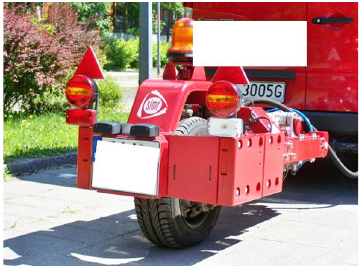
Figure 2. Single-wheel dynamometer trailer